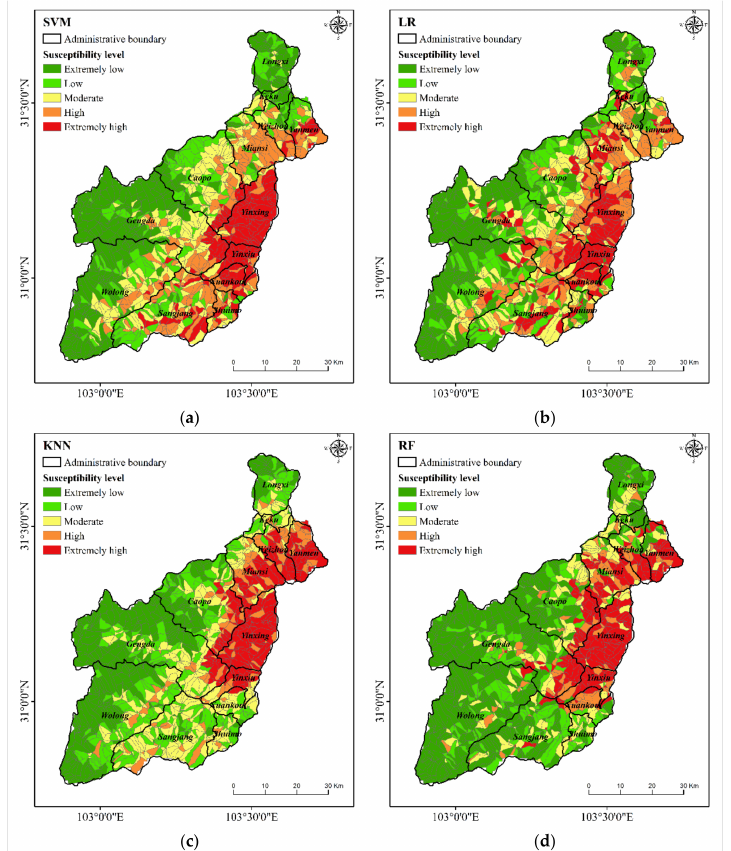
Figure 11. Landslide susceptibility maps produced by different methods: ( a ) SVM, ( b ) LR, ( c ) KNN, and ( d )